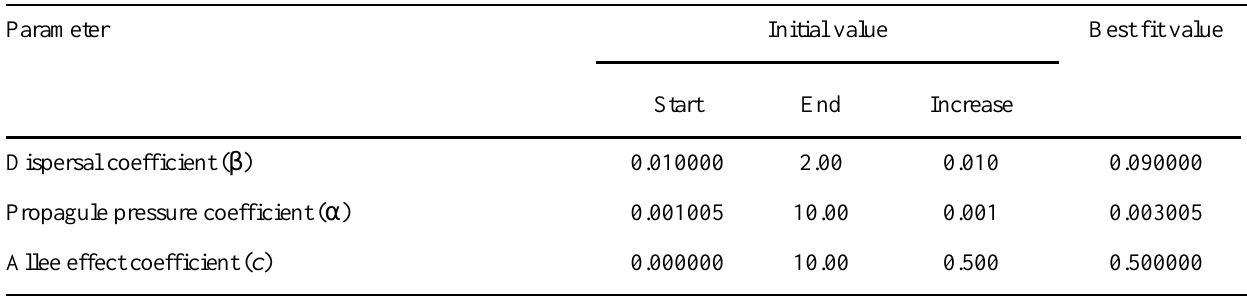
Table 4. Initial and best fitting values of parameters for the coupled map lattice